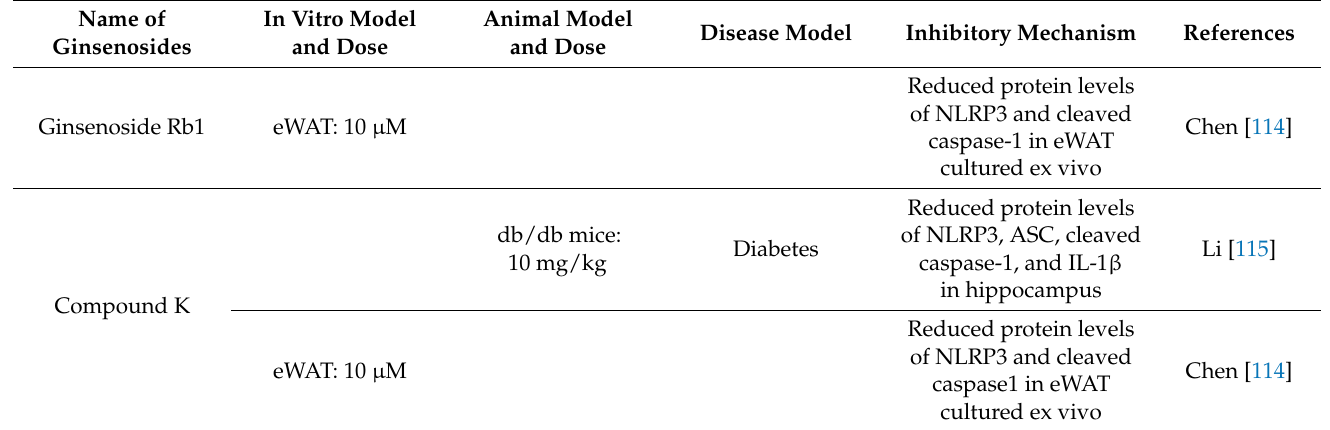
Table 2. Ginsenosides with anti-NLRP3 inflammasome